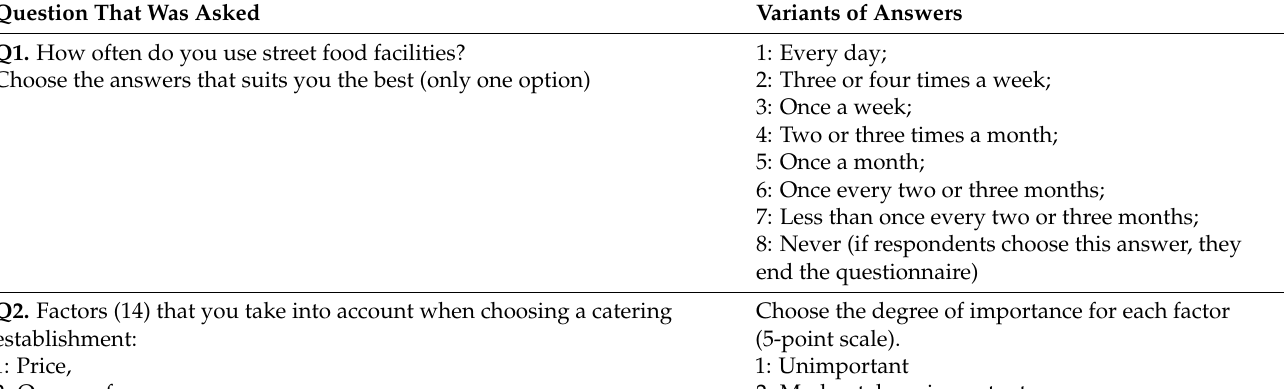
Table A1. The questionnaire used in the